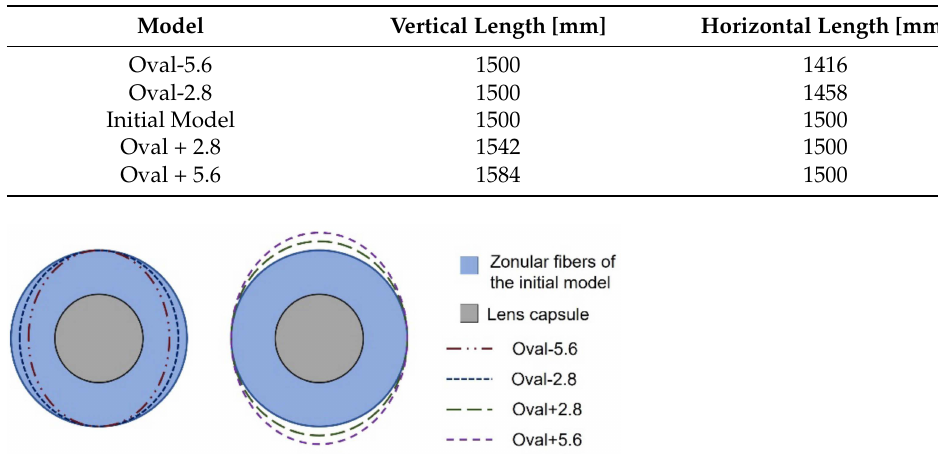
Table 1. Models developed to assess the geometry of the zonular fibers.